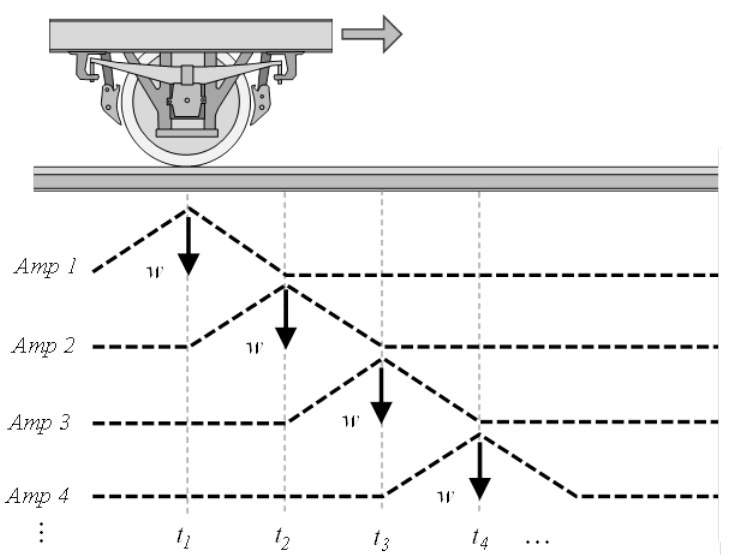
Figure 6. Train-axle loading